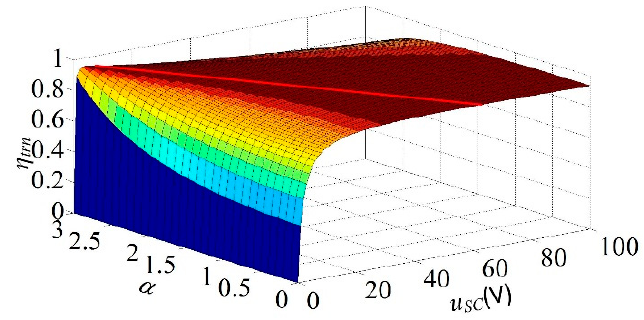
Figure 8. Transfer efficiency vs. α and u SC .